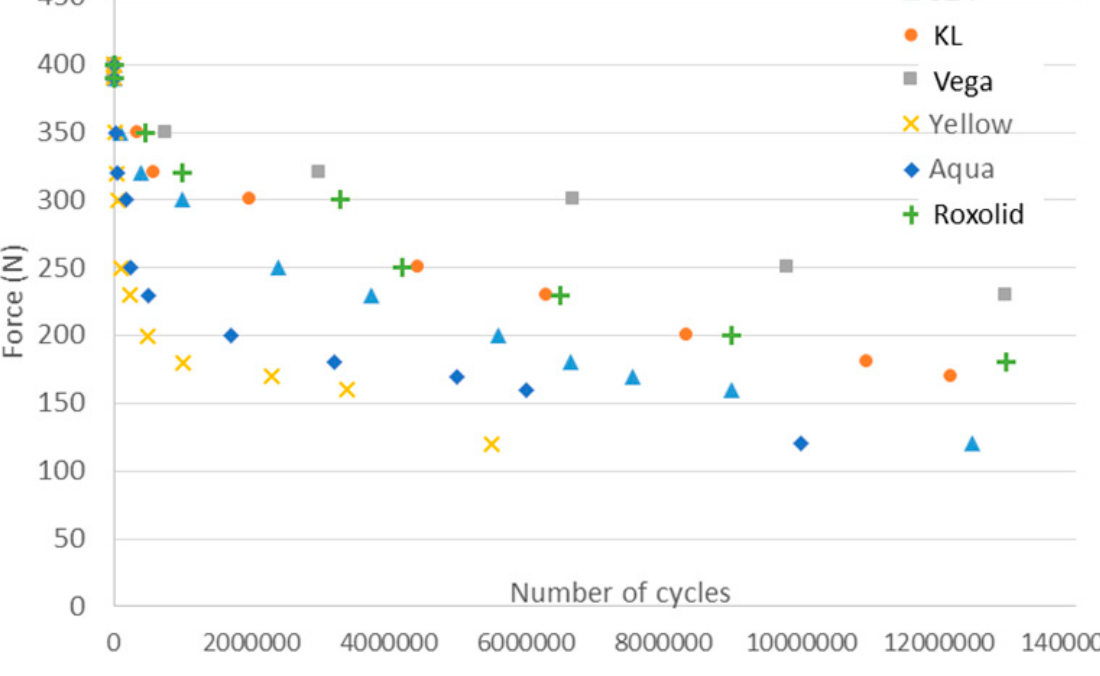
Figure 5. Crack propagation. The strained implants presented more percentage of the brittle fracture, and the other fractures were mainly ductile, corresponding to the grade 4 dental implants including the dental implants made with Ti15Zr (Figure 6). The narrow dental implants treated by cold work had lower ductility due to the difficulty of the dislocation movement. This produced lower damage of the fracture surface as can be observed in Figure 6. Ti-15Zr presented excellent mechanical properties (static and cyclic) without losing ductility.